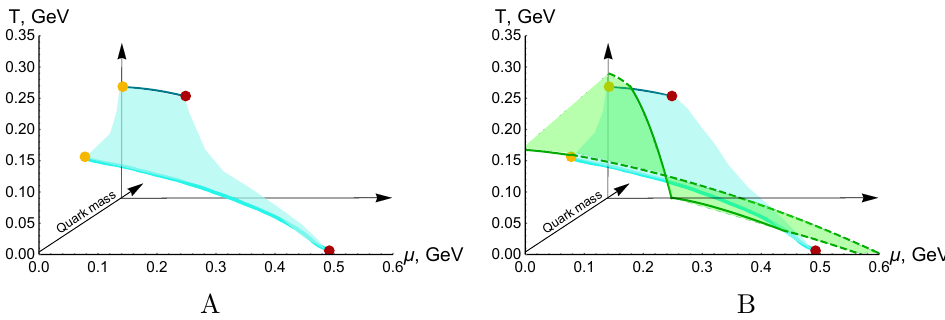
Figure 17 . Schematic pictures of phase transitions dependence on quark mass. The cyan surface shows the first order phase transition (A) and green surface shows the confinement/deconfinement transition surface (A, B). The red and yellow points are critical end